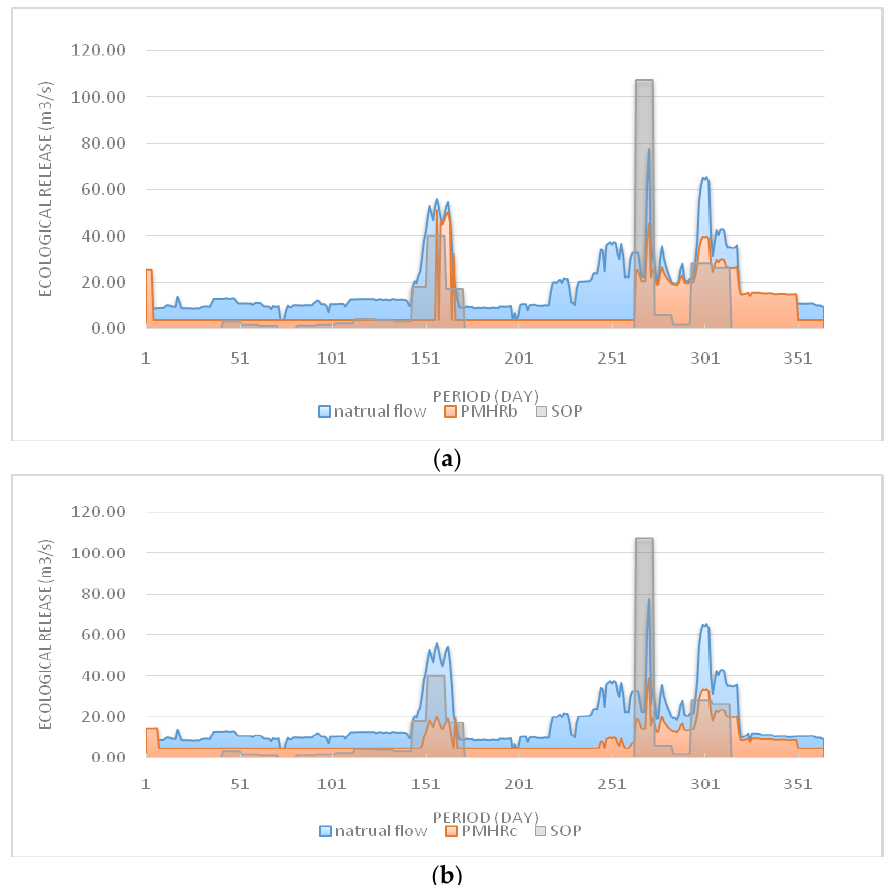
Figure 7. Comparison of release processes between different operating rules, calculated by median values. ( a ) Comparision of release process of natural flow, PMHR B and SOP; ( b ) Comparision of release process of natural flow, PMHR C and SOP.